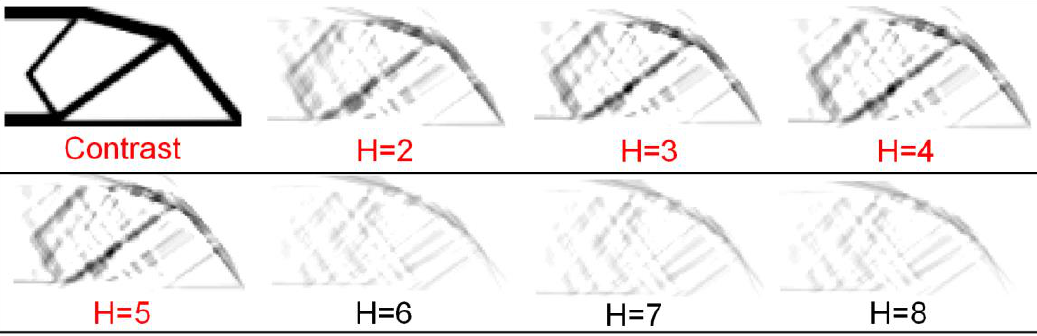
Figure 9. The prediction result of training 3 with different H.